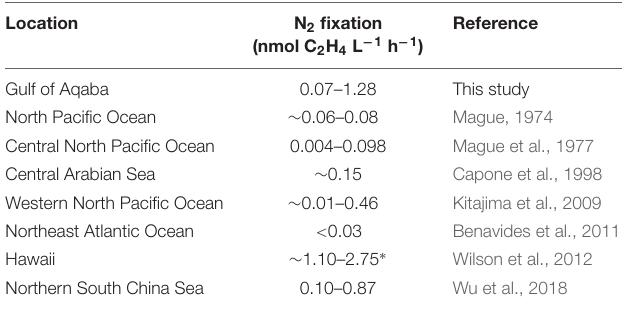
TABLE 5 | Comparison of hourly dinitrogen (N 2 ) fixation rates from this study and literature references (given as ranges) measured by acetylene reduction assay. Location